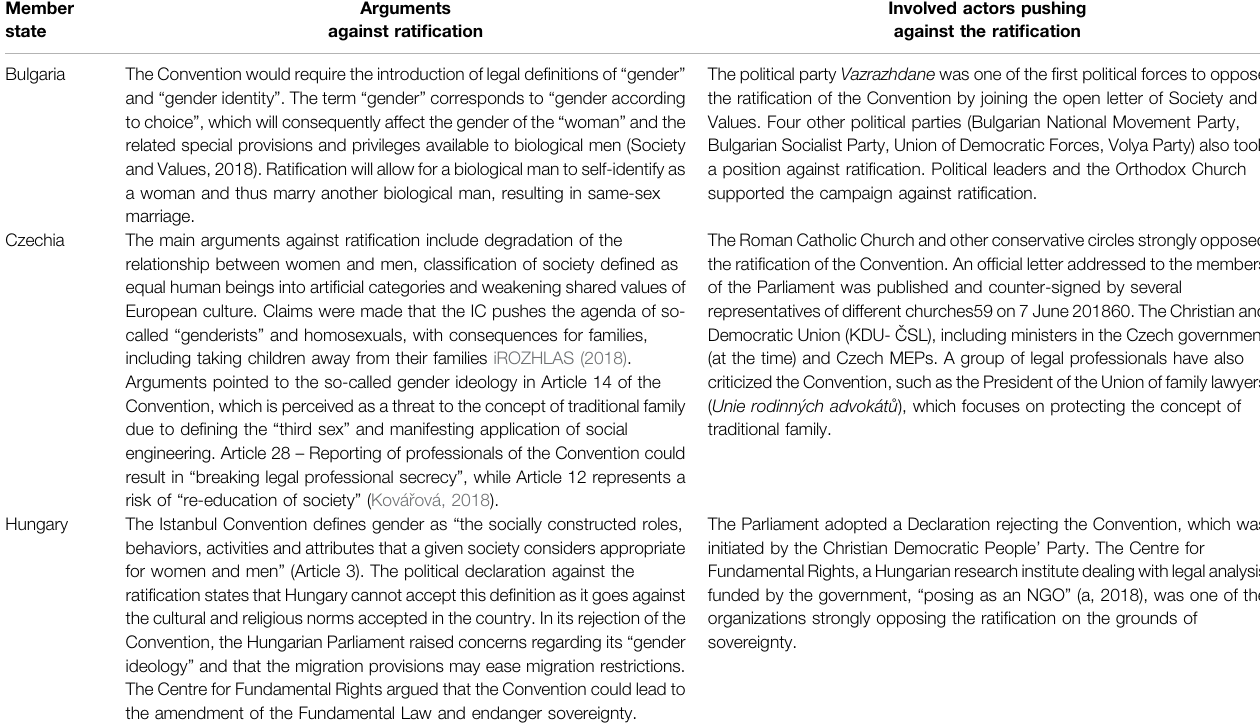
TABLE 5 | Overview of arguments and main actors against rati fi cation in the 6 non-ratifying countries (Meurens et al., 2020). Member state